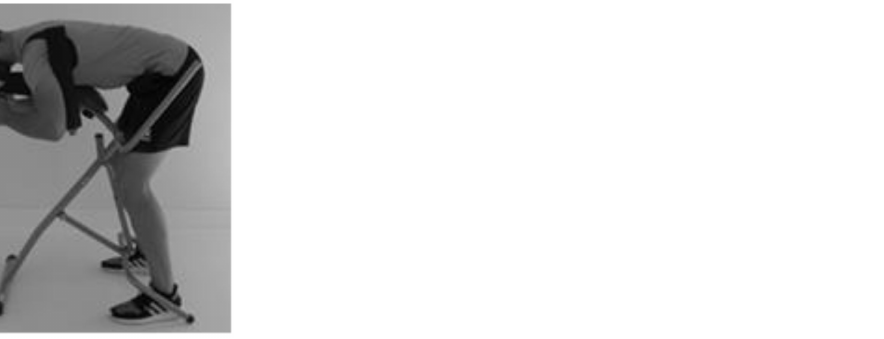
Figure 3. Use of the spinal decompressor to perform a self-traction of the thoracic and lumbar